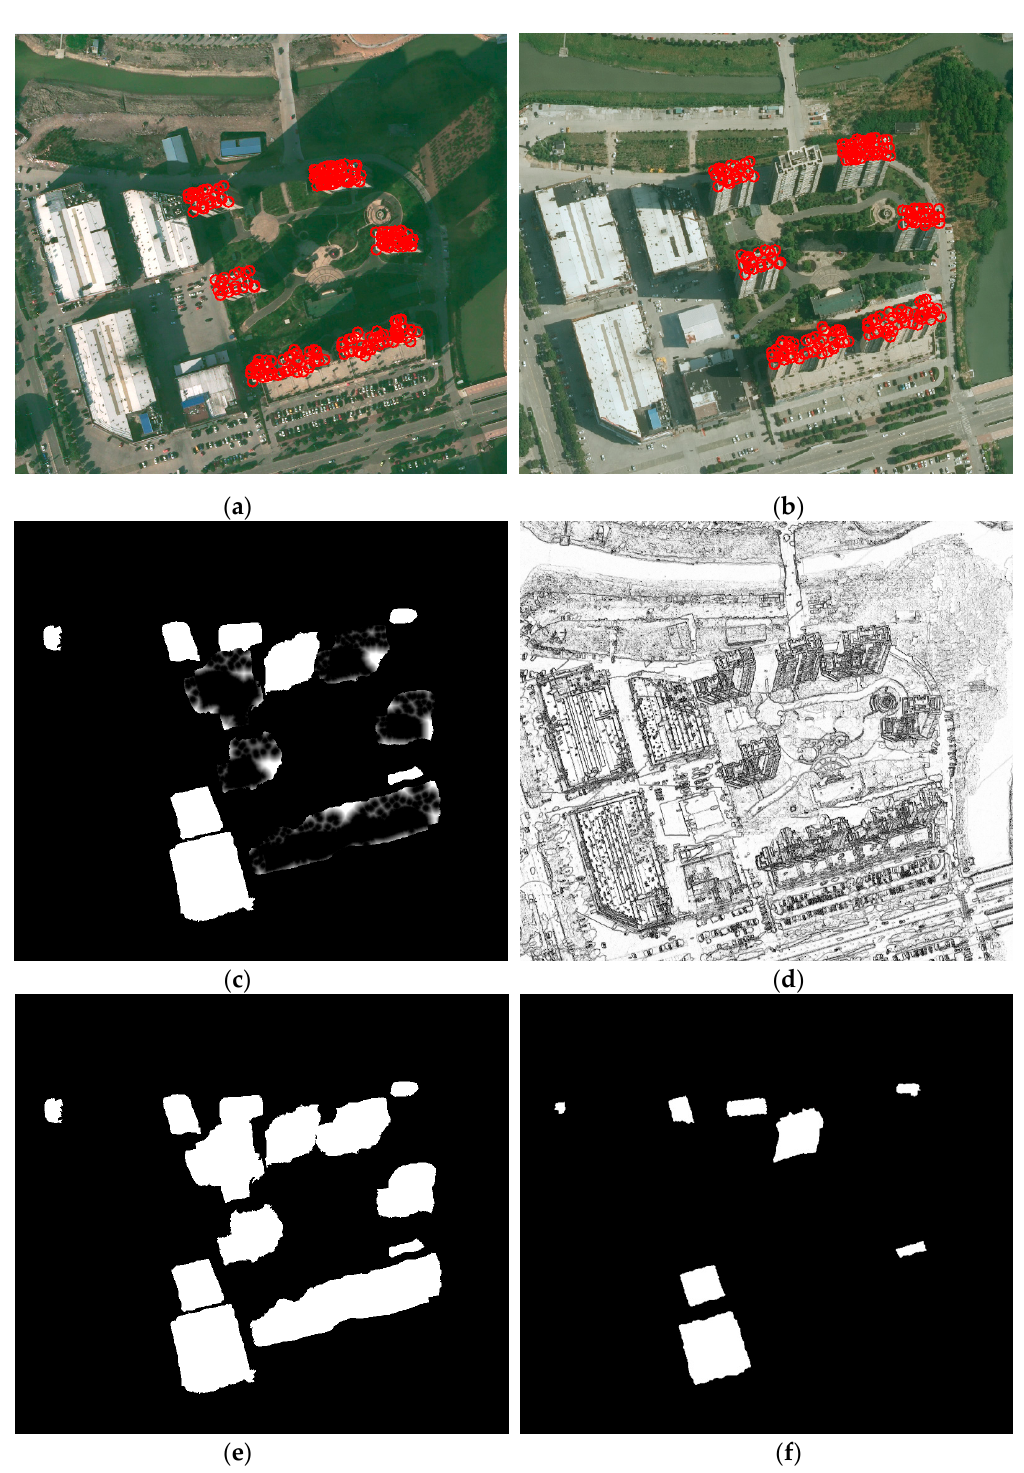
Figure 9. Co-refinement with CRF. ( a ) The buffers of the matched points on the roofs of images at times t 1 and ( b ) t 2 ; ( c ) the unchanged portions in each connected region M p ; ( d ) the converged appearance similarity of the bi-temporal images; ( e ) all changed building proposals in the bi-temporal images and ( f ) the final building change result